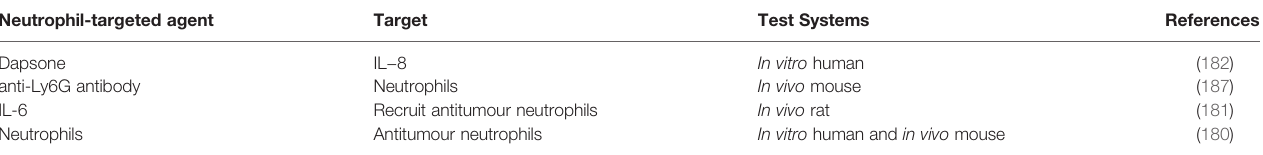
TABLE 2 | Studies to treat glioma by targeting